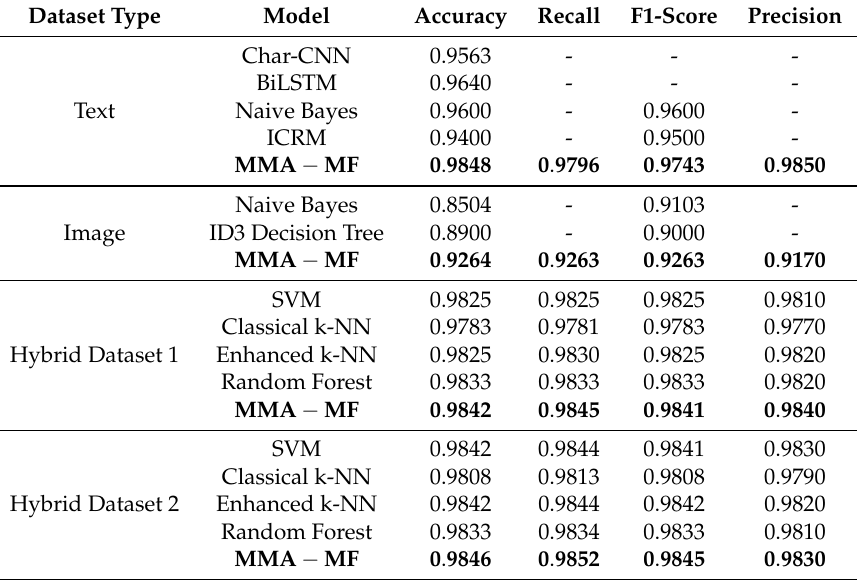
Table 8. Comparison of experimental results on different